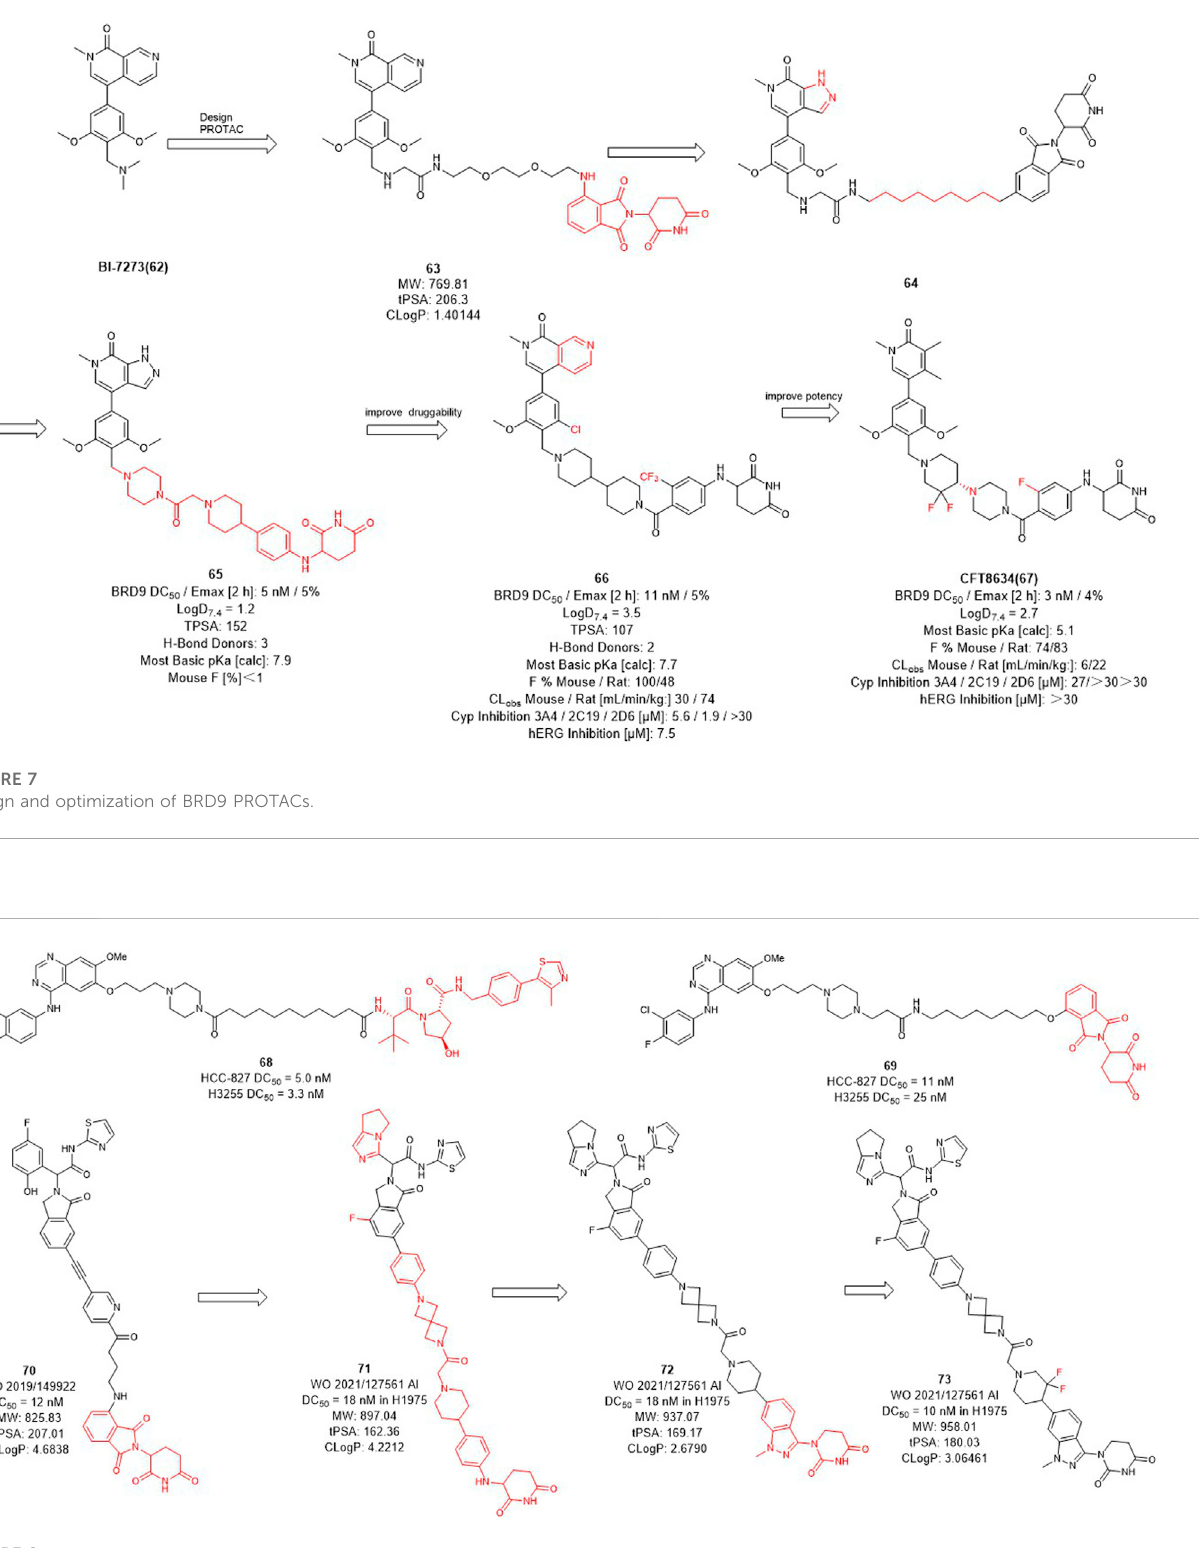
FIGURE 8 Design and optimization of EGFR L858R